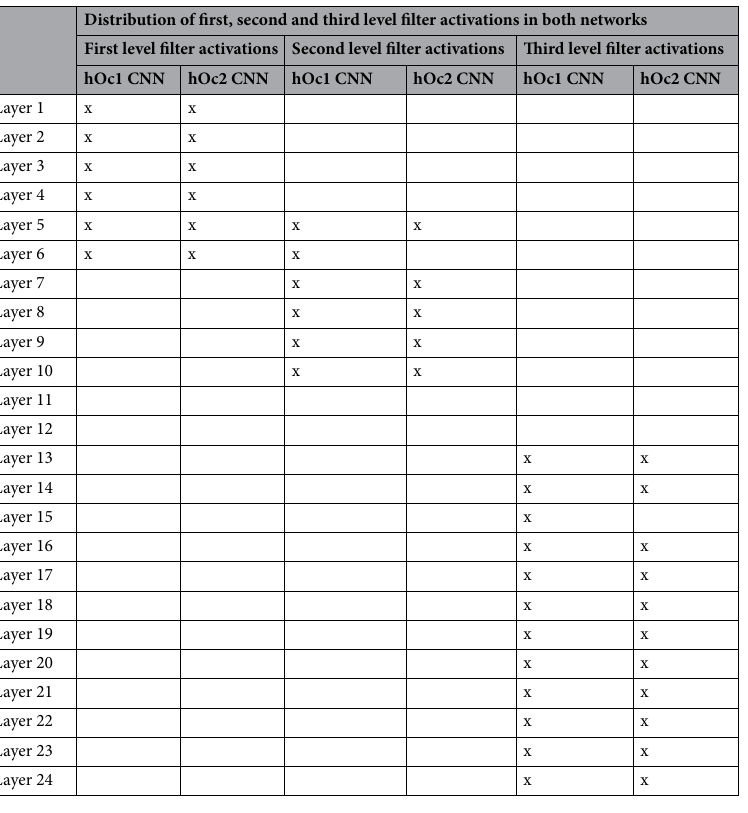
Table 1. Distribution of first, second and third level filter activations among the network layers of the two CNNs. The requirements for a filter activation to be classified as a first, second or third level filter activation are described in the methods section. Crossmarks indicate the existence of first, second or third level filter activations among the characteristic filter activations of a specific network